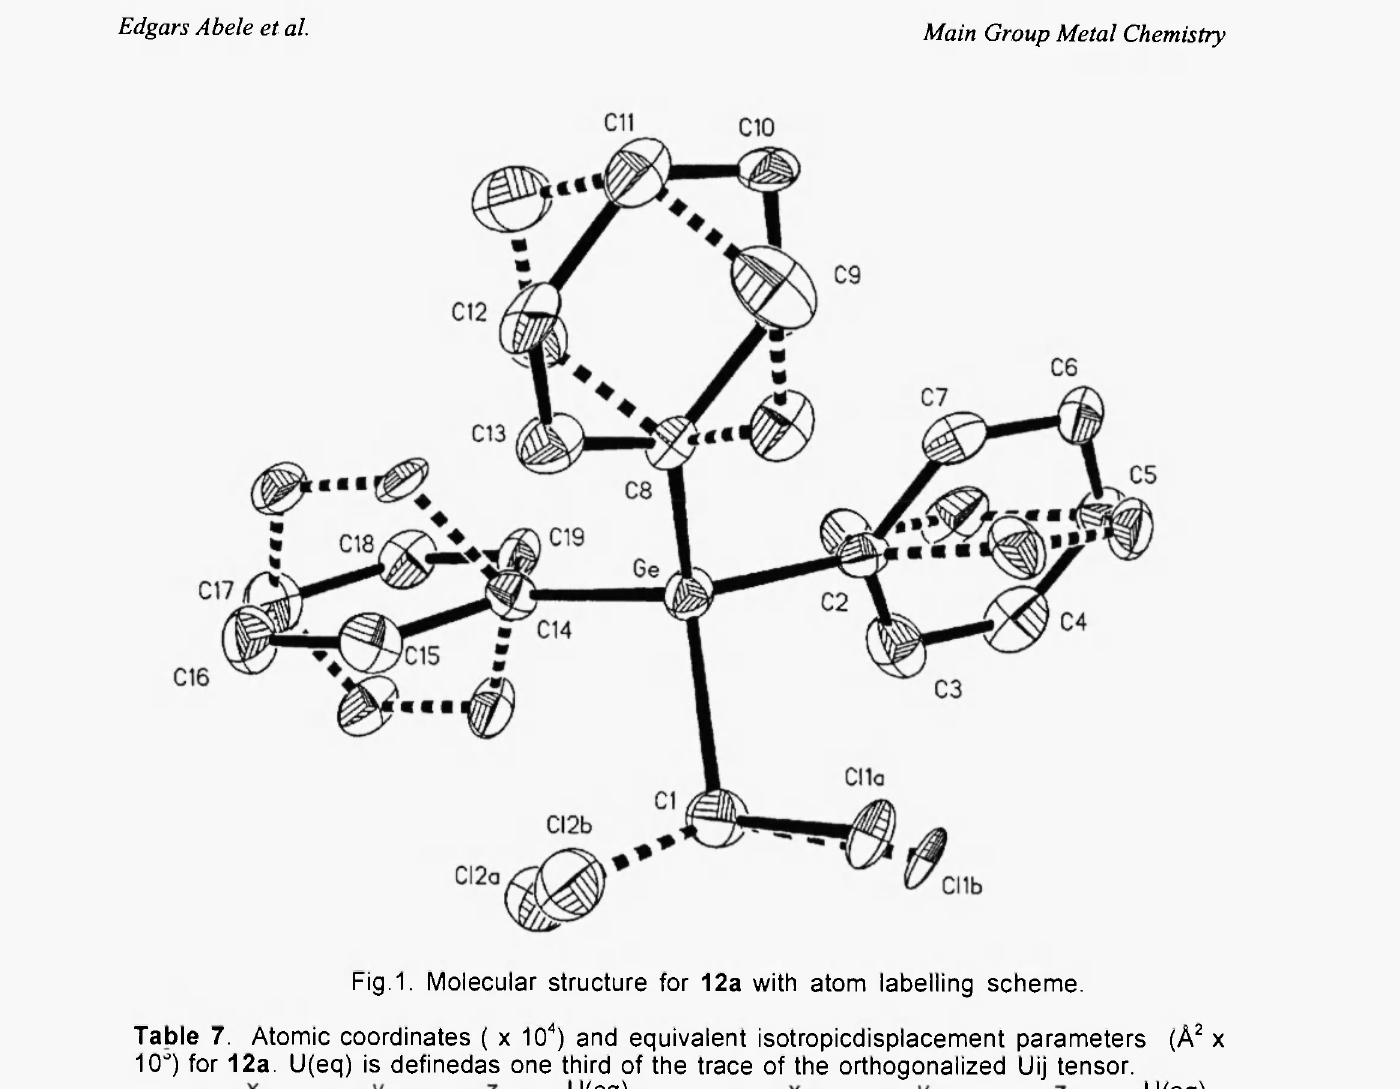
Fig. 1. Molecular structure for 12a with atom labelling scheme. Table 7. Atomic coordinates ( χ 10 4 ) and equivalent isotropicdisplacement